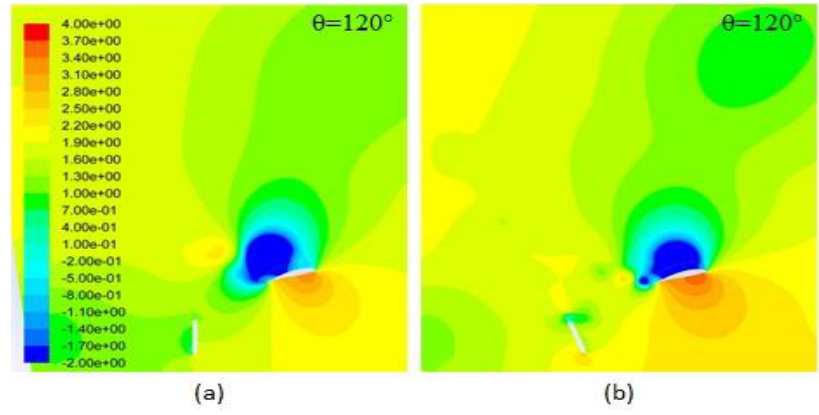
Figure 15. Total torque coefficient of five blades.